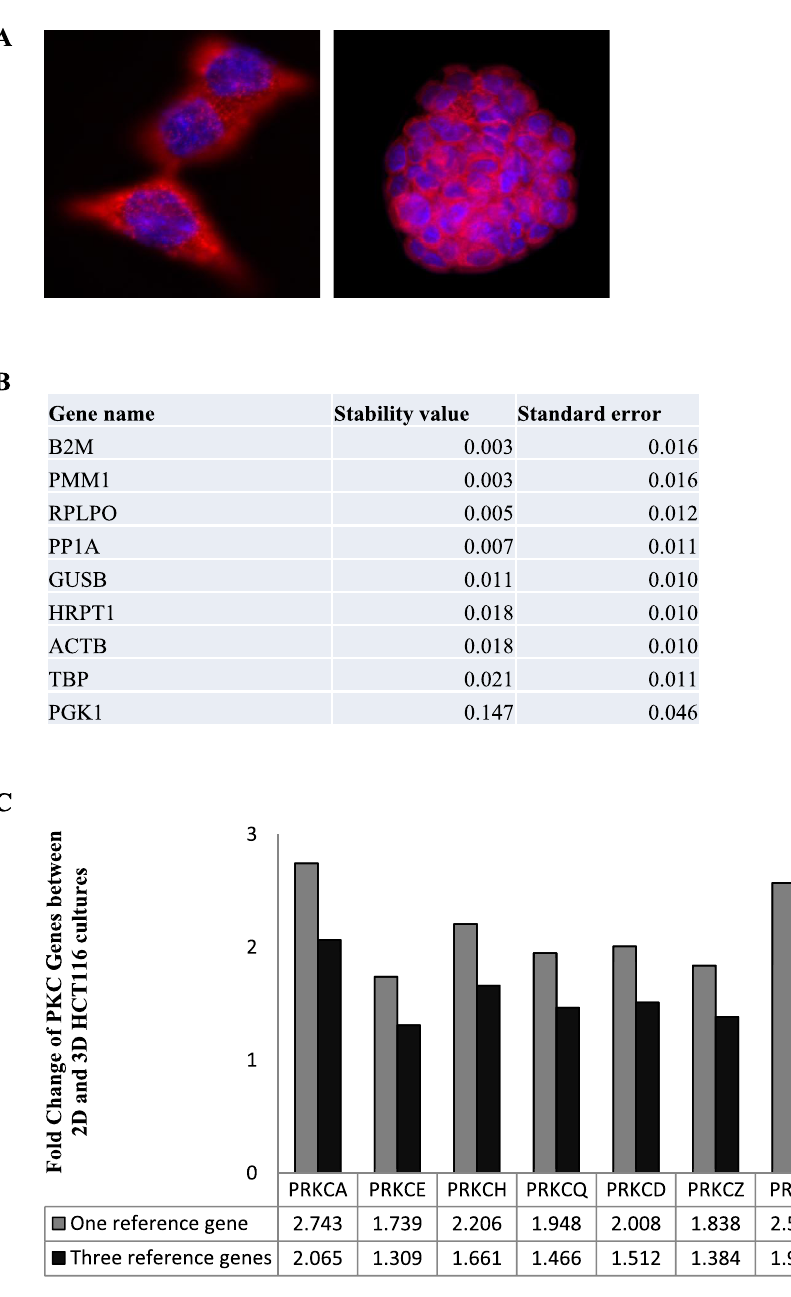
Figure 1. Reference genes in 2-dimensional and 3-dimensional HCT116 cultures. The stability of the nine candidate reference genes between 2D and 3D HCT116 cultures was analysed using NormFinder. ( A ) Immunofluorescence images of HCT116 cells in 2D (100X) (left panel) and 3D (right panel) cell cultures (63X). ( B ) Table displaying the stability levels of the nine candidate reference genes between the 2D and 3D cultures. ( C ) Graph representing the fold change of PKC coding genes in 3D cultures compared to 2D cultures when using one reference gene (B2M) versus three reference genes (B2M, PMM1 and